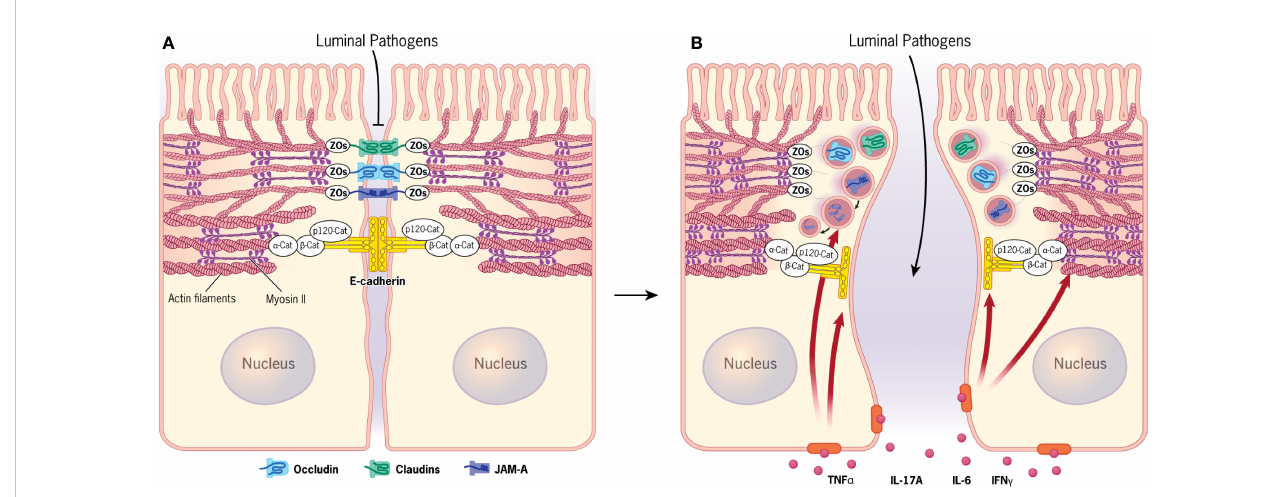
FIGURE 1 Apical junctions in normal and in fl amed intestinal epithelium. (A) Normal intestinal epithelial barrier is established by assembly of tight junctions and adherens junctions. Both junctional complexes are physically associated with the circumferential cytoskeletal belt containing actin bundles and myosin II fi laments. (B) Signaling by different cytokines accumulating in the in fl amed intestinal mucosa triggers disruption of the epithelial barrier that is driven by removal of junctional proteins from the intercellular contacts and remodeling of the perijunctional actomyosin cytoskeleton. Figure 1 by Gwendolyn Fuller, MFA. Reprinted with the permission of the Cleveland Clinic Center for Medical Art & Photography © 2023. All Rights